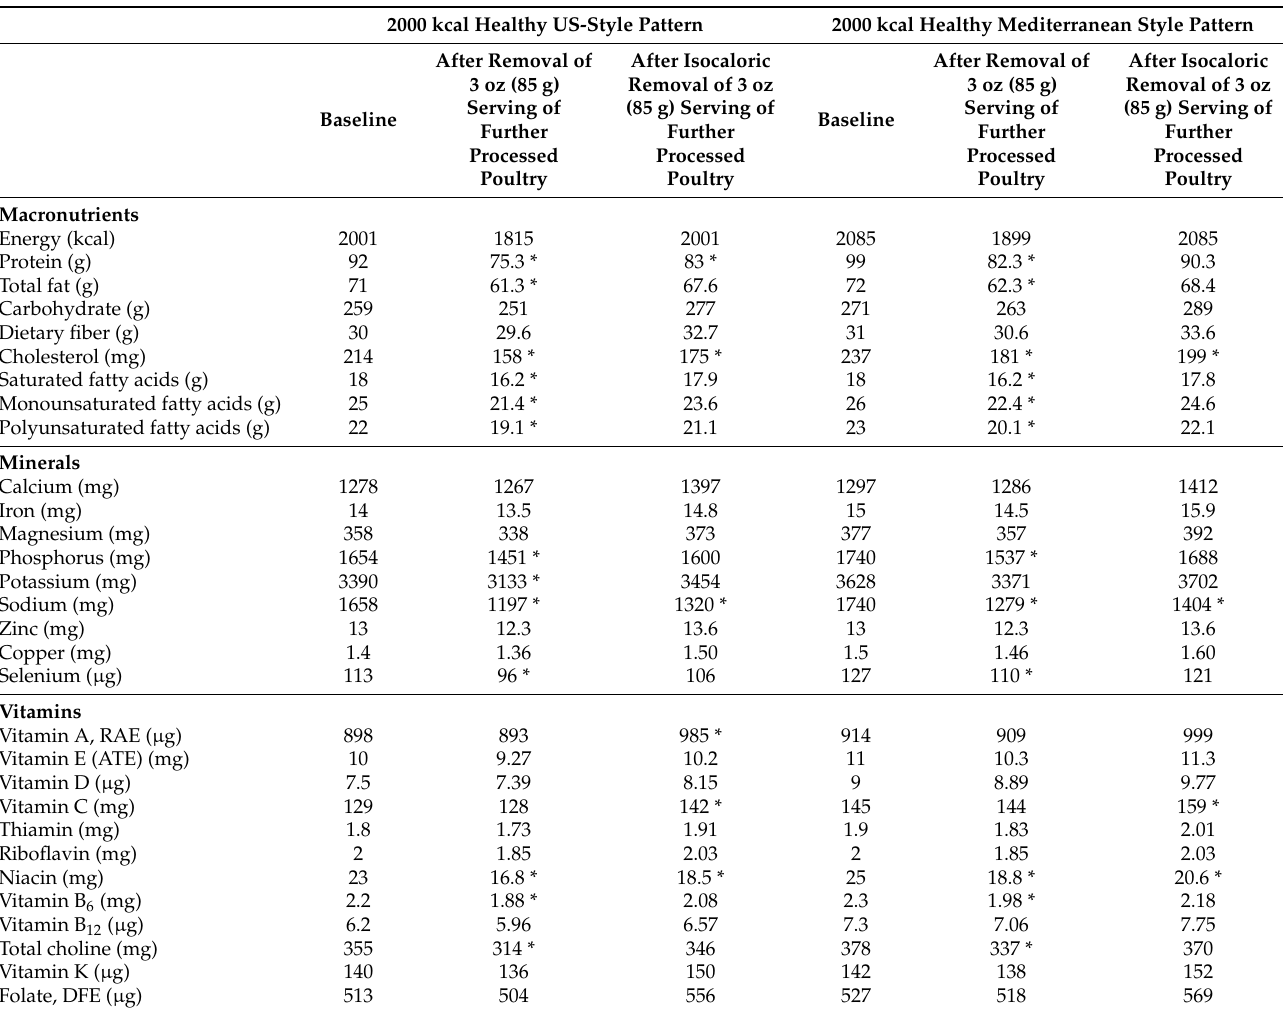
Table 7. Energy and nutrients in 2000 kcal Healthy Dietary Pattern before and after removal of a 3 oz (85 g) serving of further processed